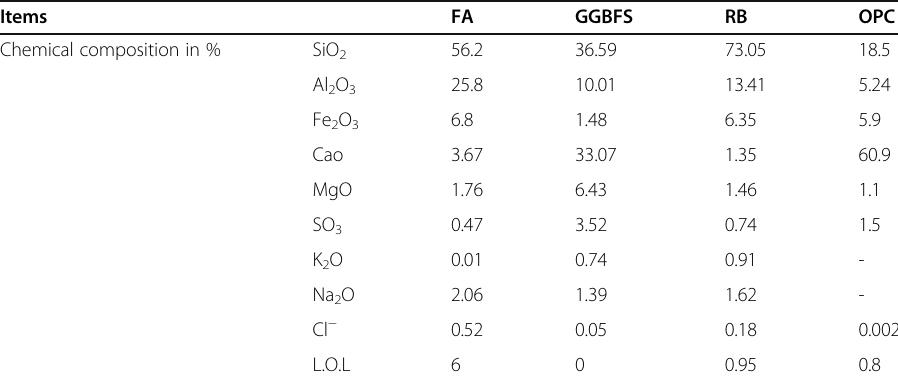
Table 1 Oxide composition (wt%) of the raw materials, X-ray fluorescence (XRF) analysis of F.A., GGBFS, R.B., and OPC